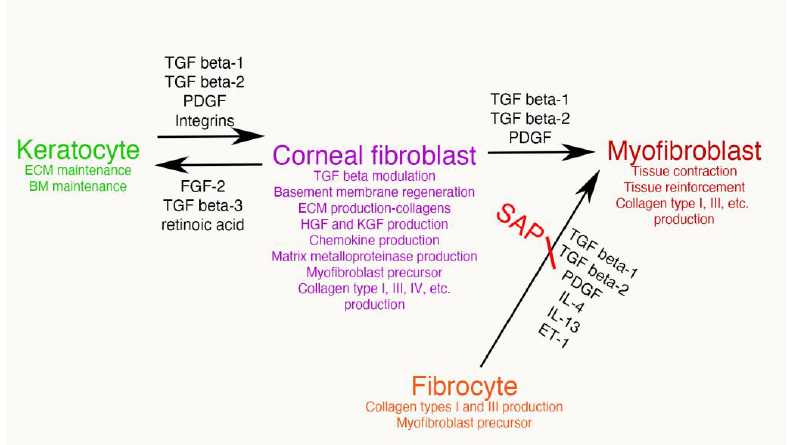
Figure 4. Mesenchymal cells of the injured corneal stroma. The unwounded corneal stroma is populated mostly with keratocytes, with a few nerve cells and resident dendritic cells. At the site of injury, driven by TGF beta-1 and TGF beta-2, along with PDGF and integrin signaling, keratocytes